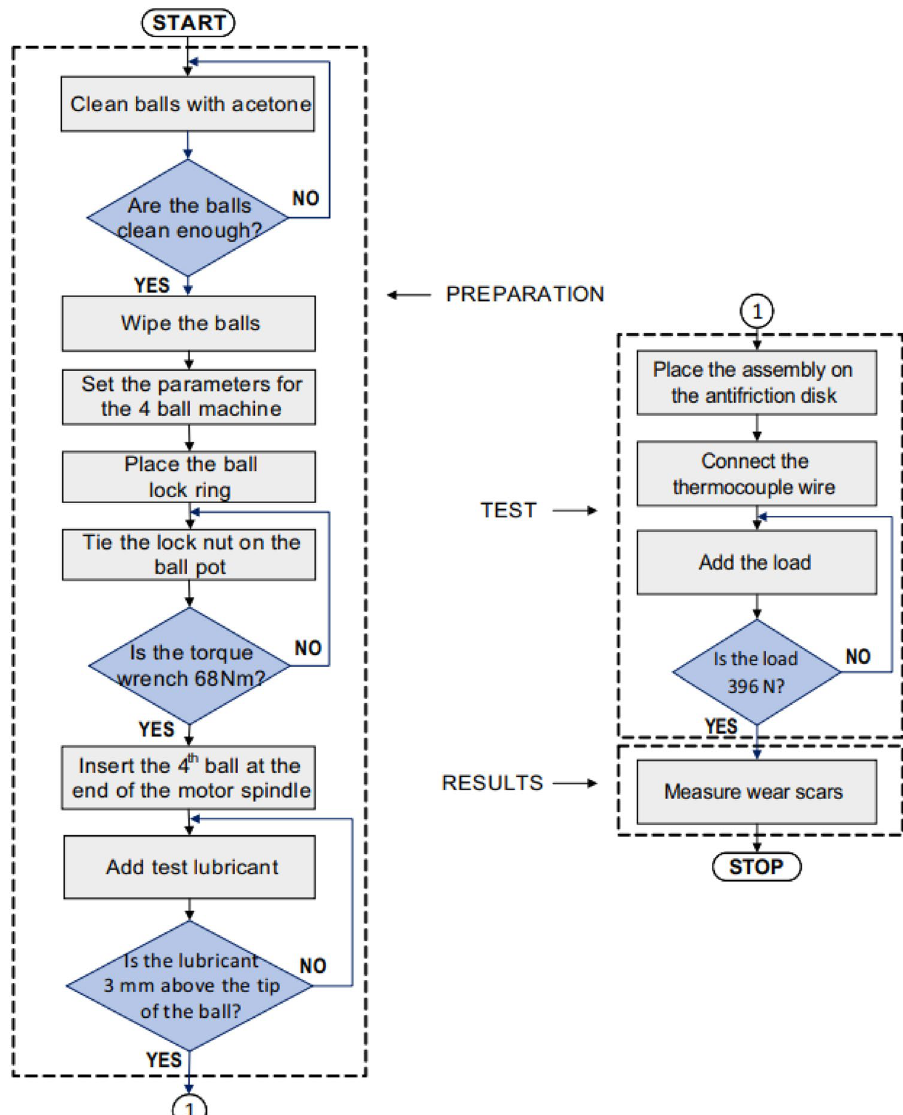
Figure 5. Four-ball tribometer—flow chart experimental